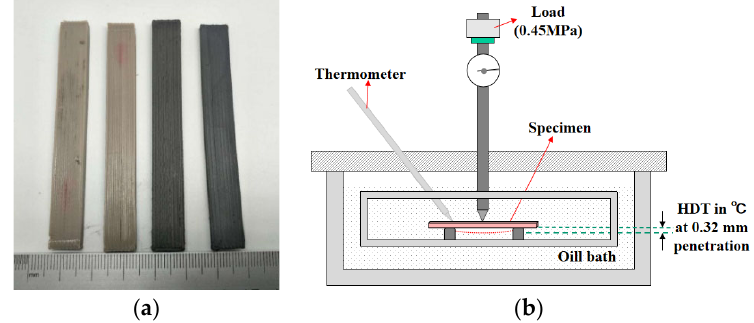
Figure 8. Heat deflection temperature (HDT) by Vicat: ( a ) Test pieces for HDT and ( b ) deformation and vicat softening temperature tester.